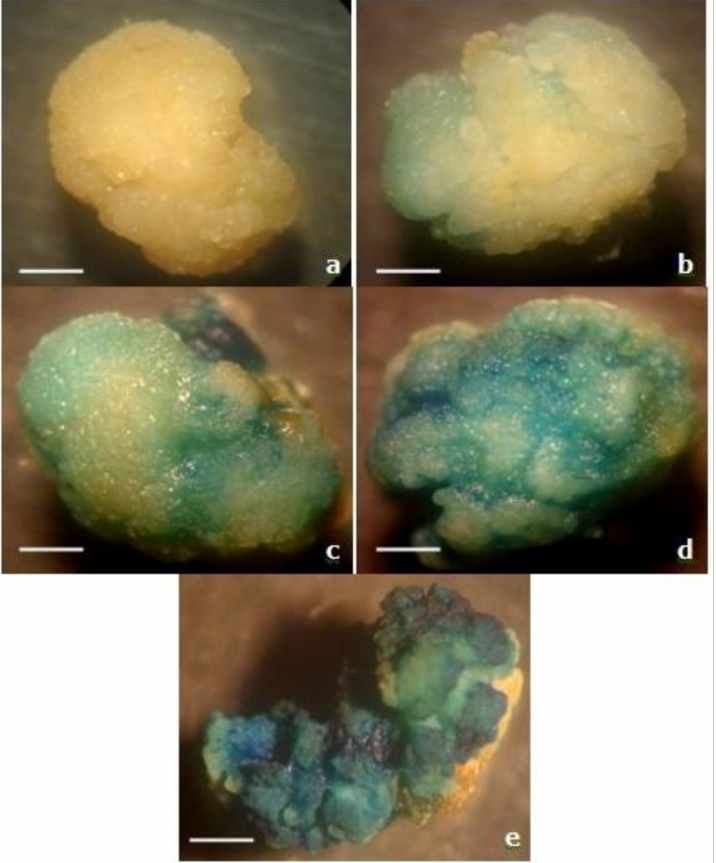
Figure 3. Microscopic observation of the rice calli stained with different blue stain intensities after GUS buffer immersion (magnification = 20 × , bar = 0.15 cm). ( a ) Non-transformed callus (Scoring: -), ( b ) callus with light blue stain (scoring: X), ( c ) callus with medium blue stain (scoring: XX), ( d ) callus with deep blue stain (scoring: XXX), and ( e ) callus with dark blue stain (scoring: XXXX).